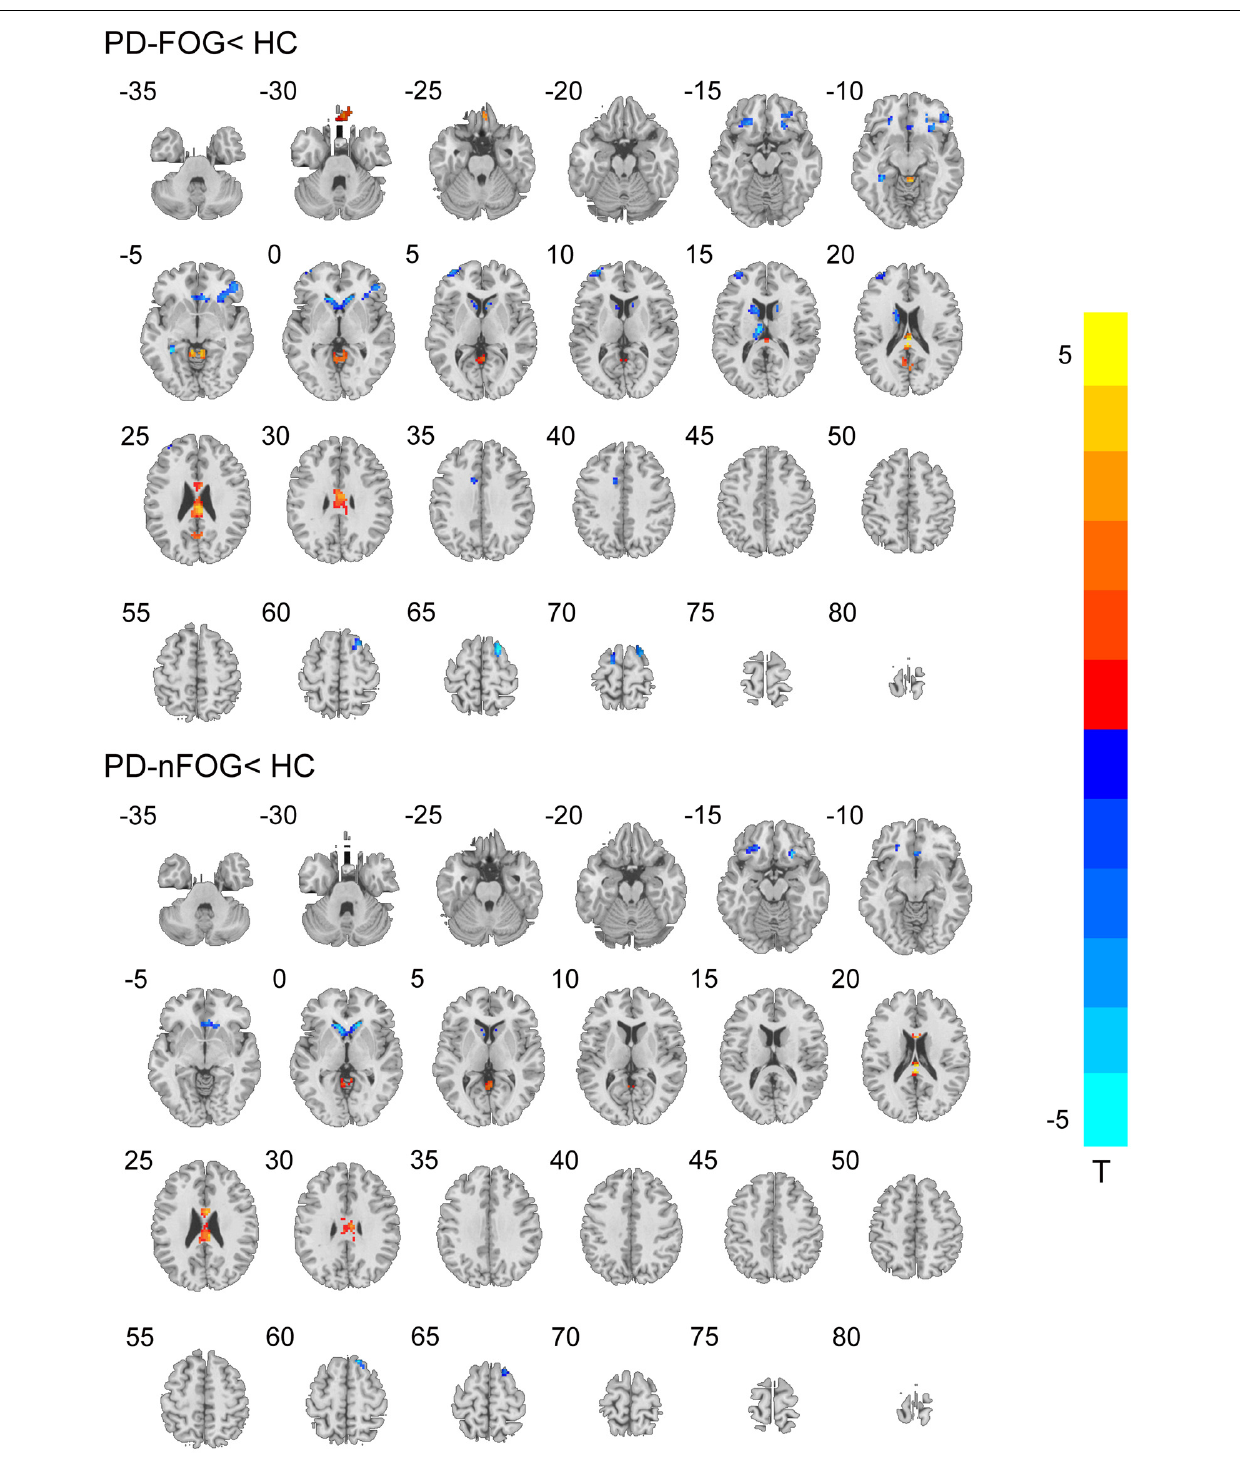
Frontiers in Neuroscience |